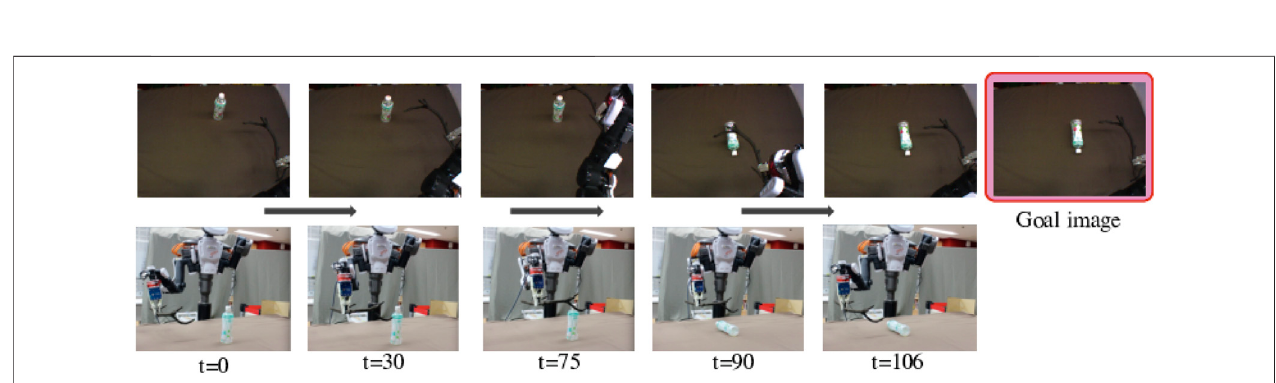
FIGURE 9 | Result of Generalization Evaluation with a PET bottle and a tree branch shown in the bottom of Figure 2 . We provided a goal image showing the PET bottle toppled forward. The robot could properly detect features and generate motions to pull forward from a high position, reproducing the situation in the goal image.